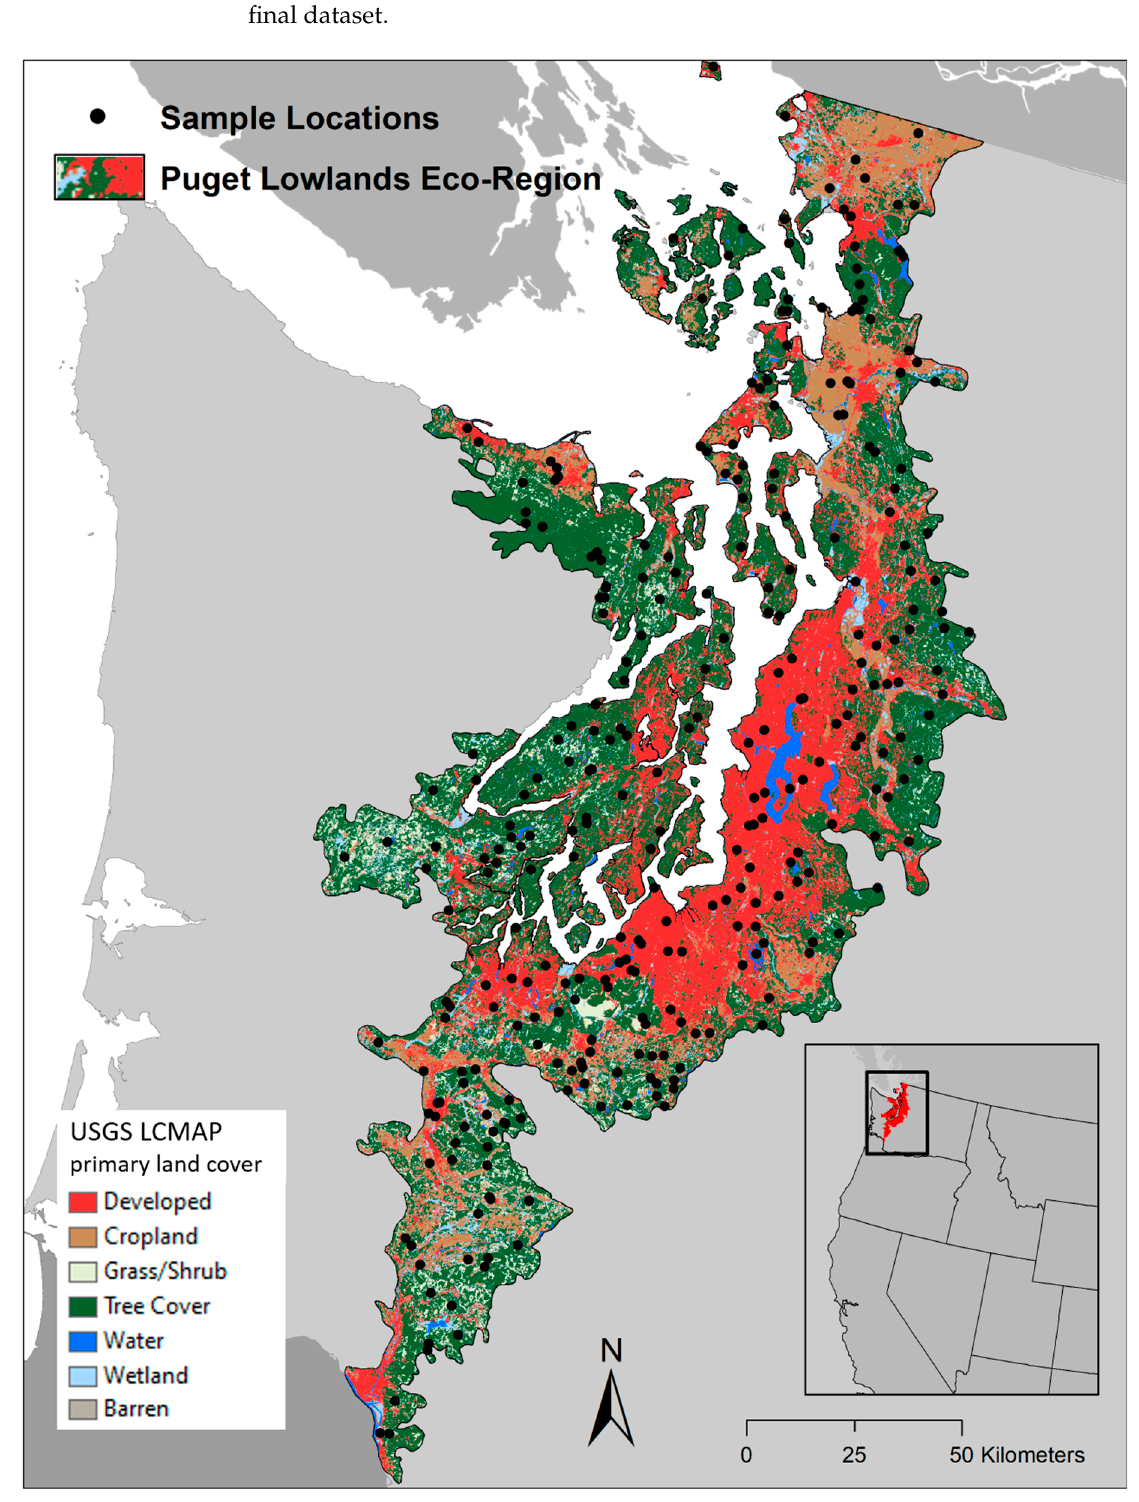
Figure 1. Spatial distribution of the 300 sample pixels in the Puget Sound region of Washington State in the northwest United States.